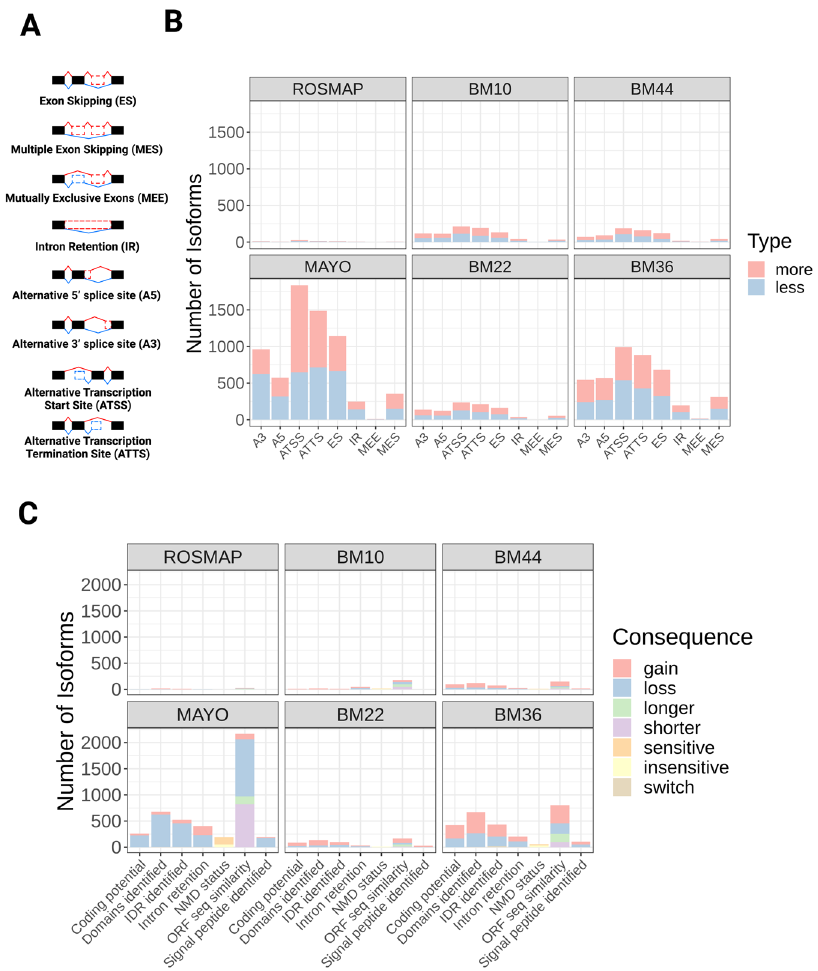
Fig. 5 Alternative splicing mechanisms associated with isoform switches and consequences for protein expression. A Schematic showing different splicing events that can lead to gene isoform switches. B Quanti fi cation of the number of isoforms showing more or less splicing events in AD compared to controls for each dataset. C Quanti fi cation of the number of isoforms showing (i) gain or loss of coding potential, domains/signal peptides identi fi ed, intrinsically disordered regions (IDR), intron retention, open-reading frame (ORF) sequencing similarity; (ii) switch (simultaneous gain and loss) of domains identi fi ed or IDR; (iii) sensitive or insensitive to nonsense-mediated decay (NMD); and (iv) longer or shorter ORF sequencing